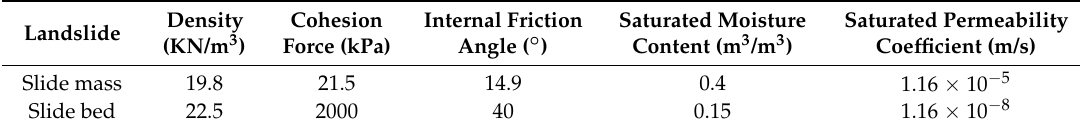
Table 1. Parameters of the Sifangbei landslide.